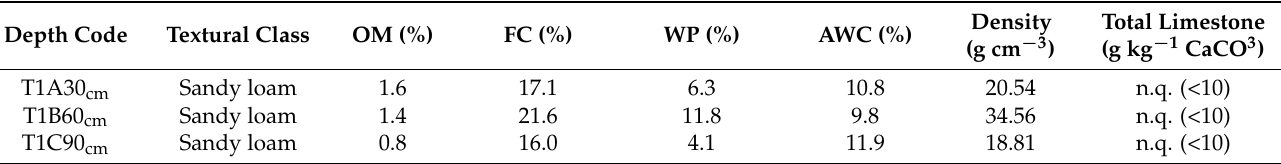
Table 4. Parameters related to the soil structure (organic matter (OM), field capacity (FC), withering point (WP), available water capacity (AWC), density, and total limestone) at different depths (i.e., 30, 60, and 90 cm). Depth